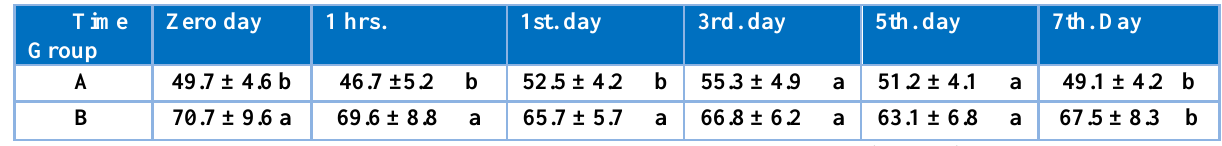
Different small letters vertically refers to the existence of significant differences (P< 0.05). Table, 2: Aspartate aminotransferase (U/L) (GOT) (AST)